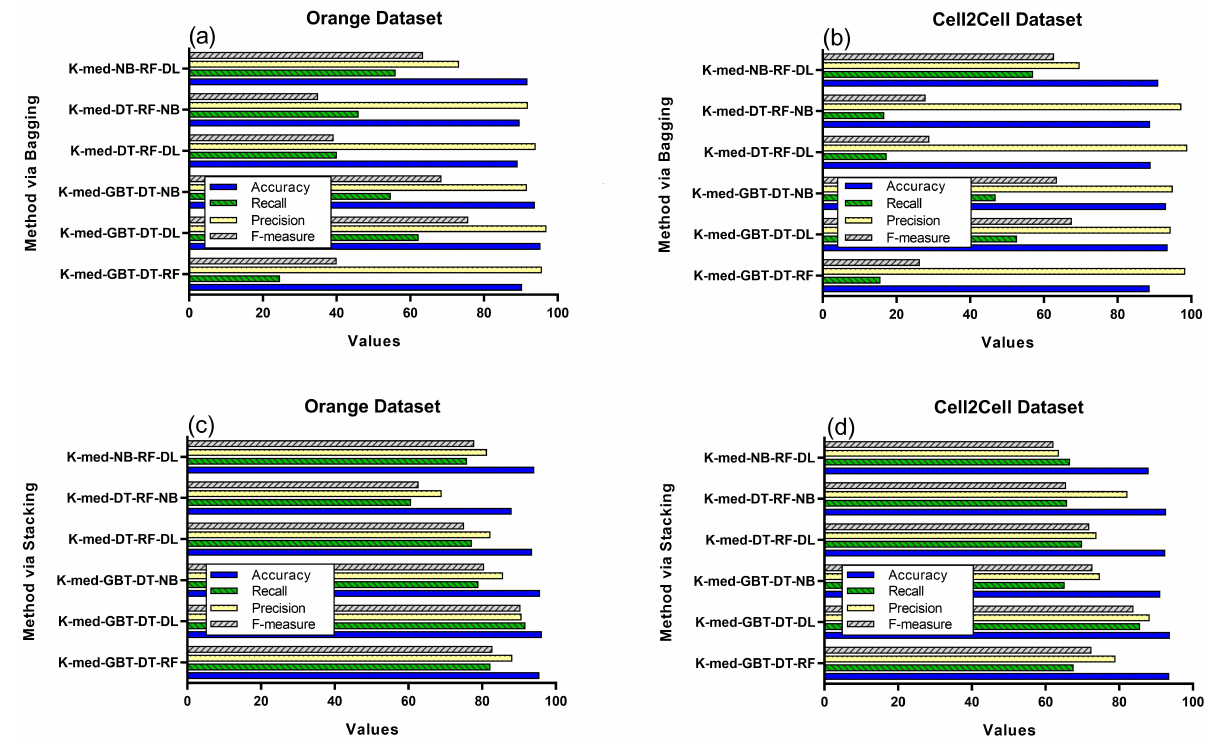
Figure 6. Represents different algorithm’s performance based on ensemble techniques ( a ) Bagging- based methods results on Orange dataset. ( b ) Bagging-based methods results on the Cell2Cell dataset. ( c ) Stacking-based methods results on the Orange dataset. ( d ) Stacking-based methods results on the Cell2Cell